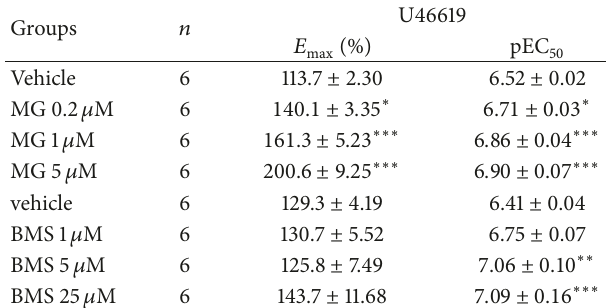
Overviewof 𝐸 max and pEC 50 values of U46619-induced contractile response on rat renal arteries. The segments were organ cultured for 24 h in presence of vehicle (control) or different concentrations of MG-132 (MG 0.2, 1, or 5 𝜇 M) or BMS345541 (BMS 1, 5, or 25 𝜇 M). Data are shown as mean ± SEM. 𝑛 denotes the number of vessel segments. One-way ANOVA with Dunnett’s multiple comparison test was used. ∗ 𝑃 < 0.05 , ∗∗ 𝑃 < 0.01 , ∗∗∗ 𝑃 <